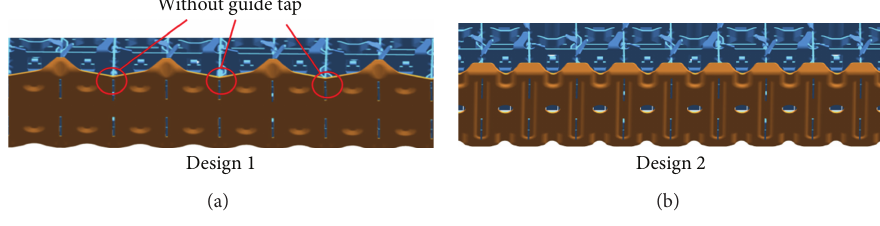
Figure 1: Schematic illustration of outer strap.